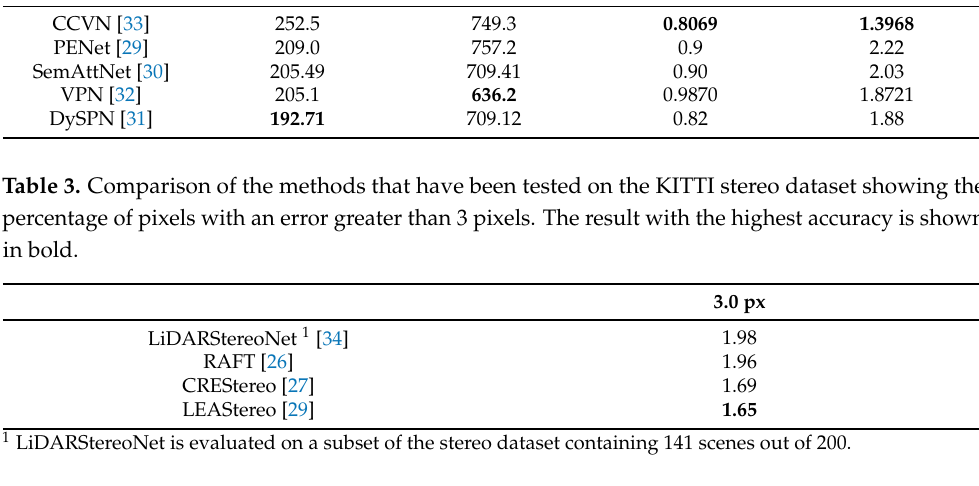
Table 4. The strengths and limitations of each